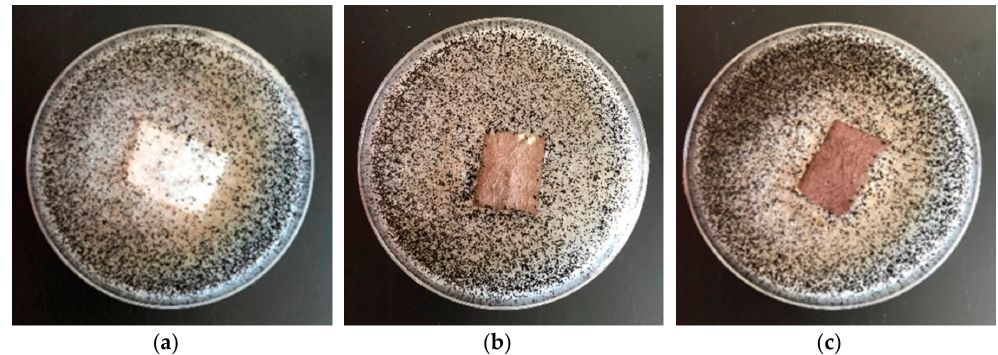
Figure 7. The sample antimicrobial activity tests against Chaetomium globosum. Inhibition properties of fungal growth on Petri dishes: ( a )—PLA, ( b )—PLA–Cu 0 (10); ( c )—PLA–Cu 0 (30).